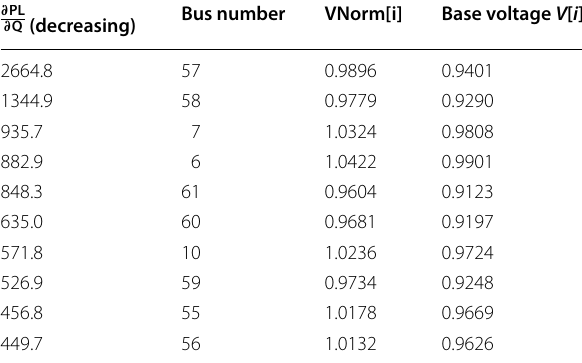
Table 3 Loss sensitivity factors for 69-bus